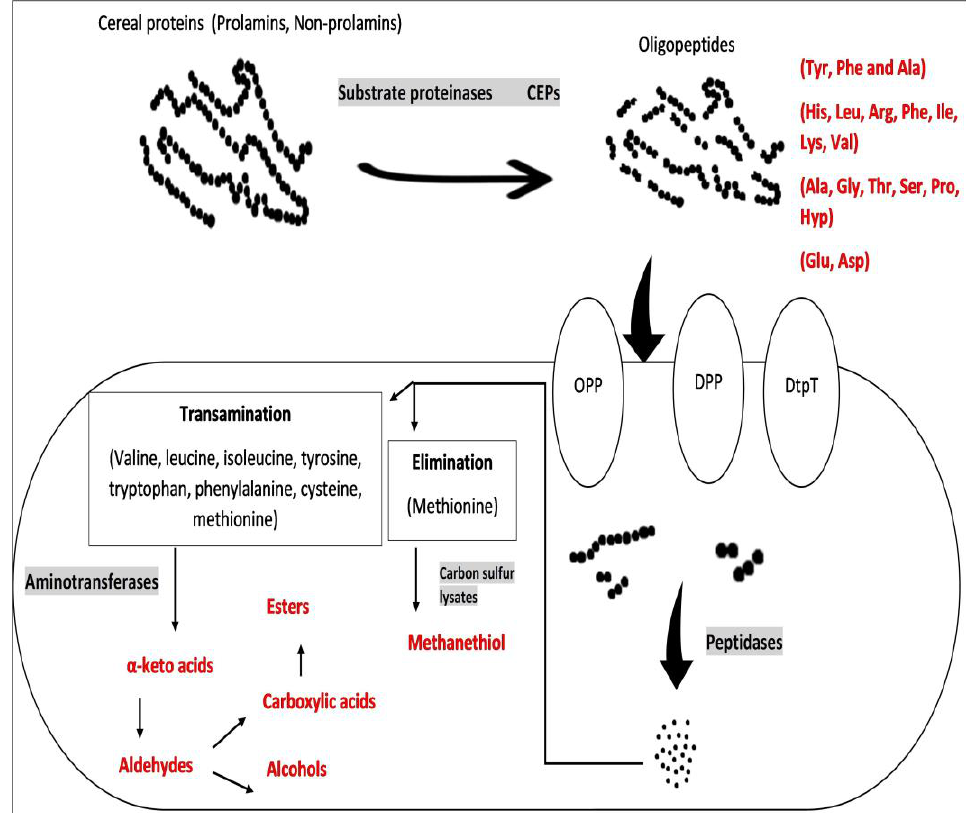
Figure 2. Protein metabolism via LAB in cereal substrates. Cell envelope proteinases (CEPs), oligopeptide permease (Opp), ion-linked transporter (DtpT), ABC transporter (Dpp). Flavour compounds labelled in red.